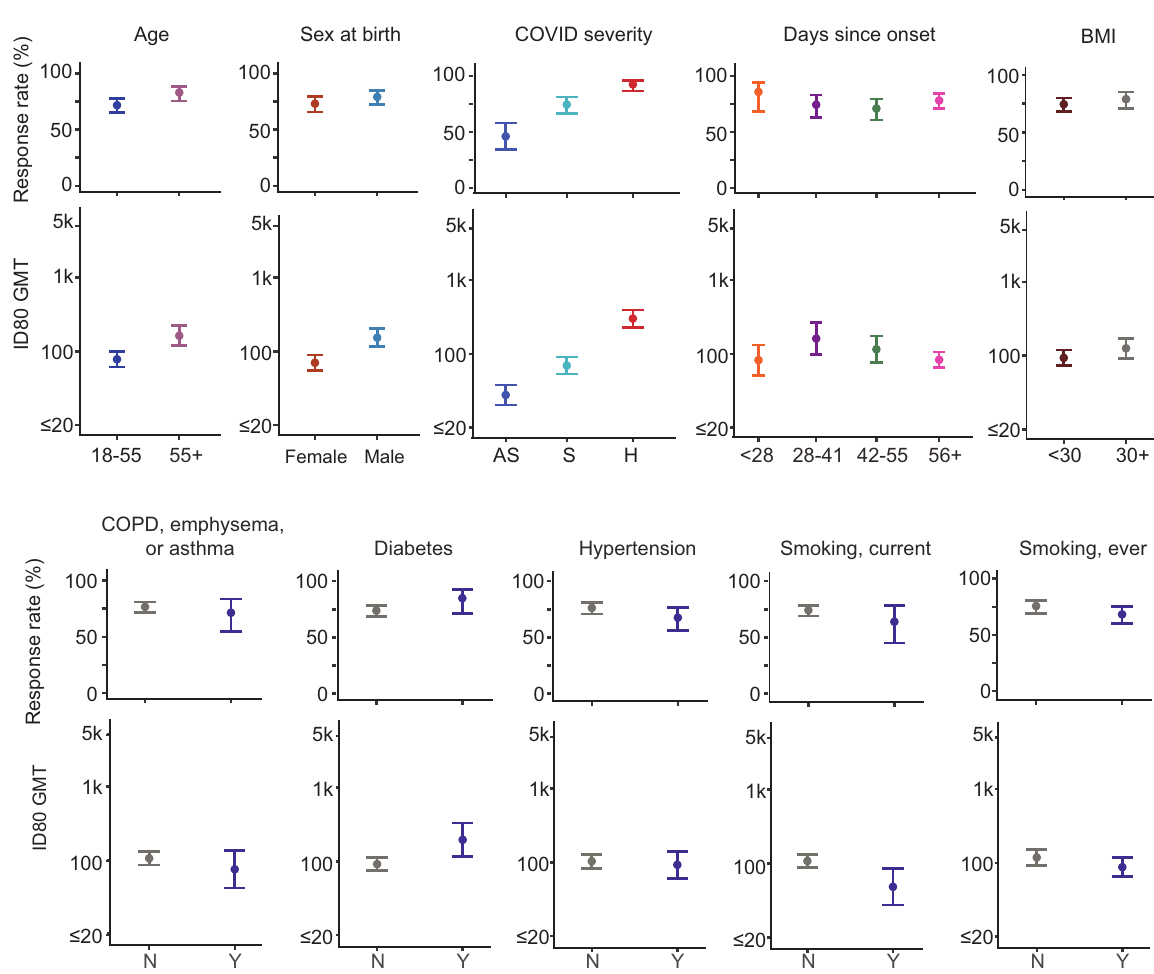
Fig 1. ID50 GMT at enrollment visit and 95% CI by enrollment group, severity, medical history, and days since SARS-CoV-2 diagnosis. CI AU : AbbreviationlistshavebeencompiledforthoseusedinFigs 1 (cid:0) 3 : Pleaseverifythatallentriesarecorrect : , confidence interval; COPD, chronic obstructive pulmonary disease; GMT, geometric mean titer; SARS-CoV-2, Severe Acute Respiratory Syndrome Coronavirus